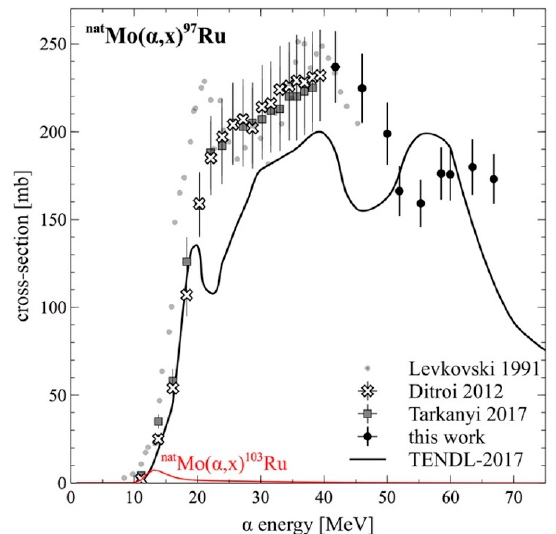
Figure 2. Measured cross-section for nat Mo( α ,x) 97 Ru reaction compared with data available in the literature. The coproduction of 103 Ru via 100 Mo( α ,n) 103 Ru and 100 Mo( α ,p) 103 Tc → 103 Ru reactions was not observed in the investigated energy range, but the cross-section for nat Mo( α ,x) 103 Ru from TENDL-2017 is plotted (red line) to complement the discussion from the text.